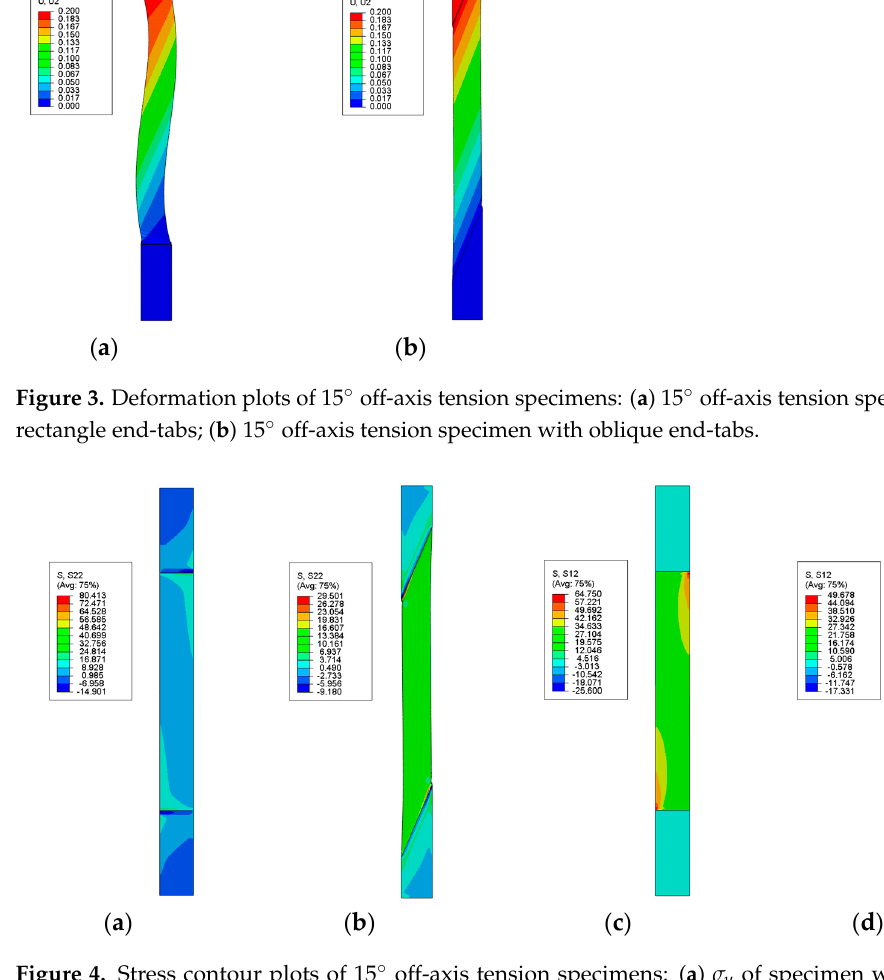
Figure 4. Stress contour plots of 15° off-axis tension specimens: ( a ) 𝜎 (cid:3052) of specimen with regular end-tabs; ( b ) 𝜎 (cid:3052) of specimen with oblique end-tabs; ( c ) 𝜏 (cid:3051)(cid:3052) of specimen with regular end-tabs; ( d ) 𝜏 (cid:3051)(cid:3052) of specimen with oblique end-tabs.